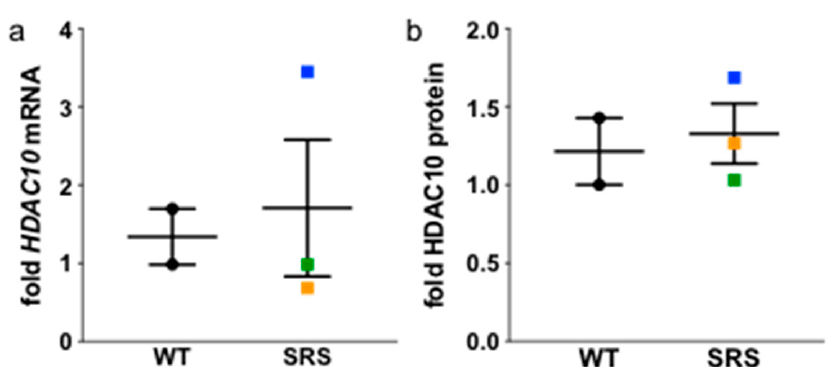
Figure 7. HDAC10 mRNA ( a ) and protein ( b ) levels in wildtype versus SRS lymphoblasts. Color designations are orange for SRS1, blue for SRS2, and green for SRS3. Error bars indicate SEM ( n = 3).